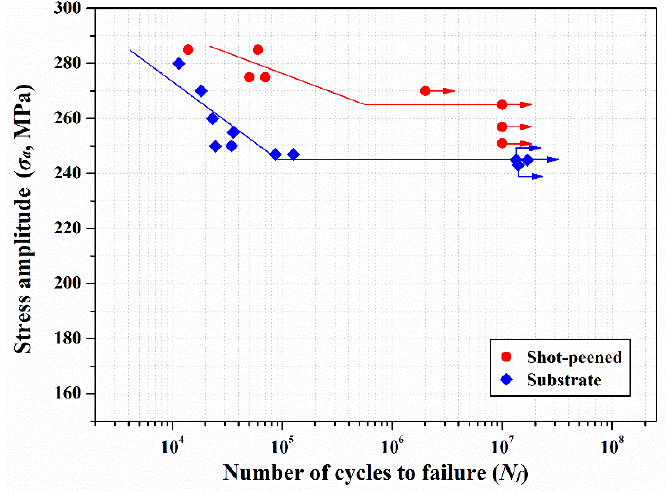
Figure 10. Fatigue stress vs. cycle curves of the 304 substrate and shot-peened samples.